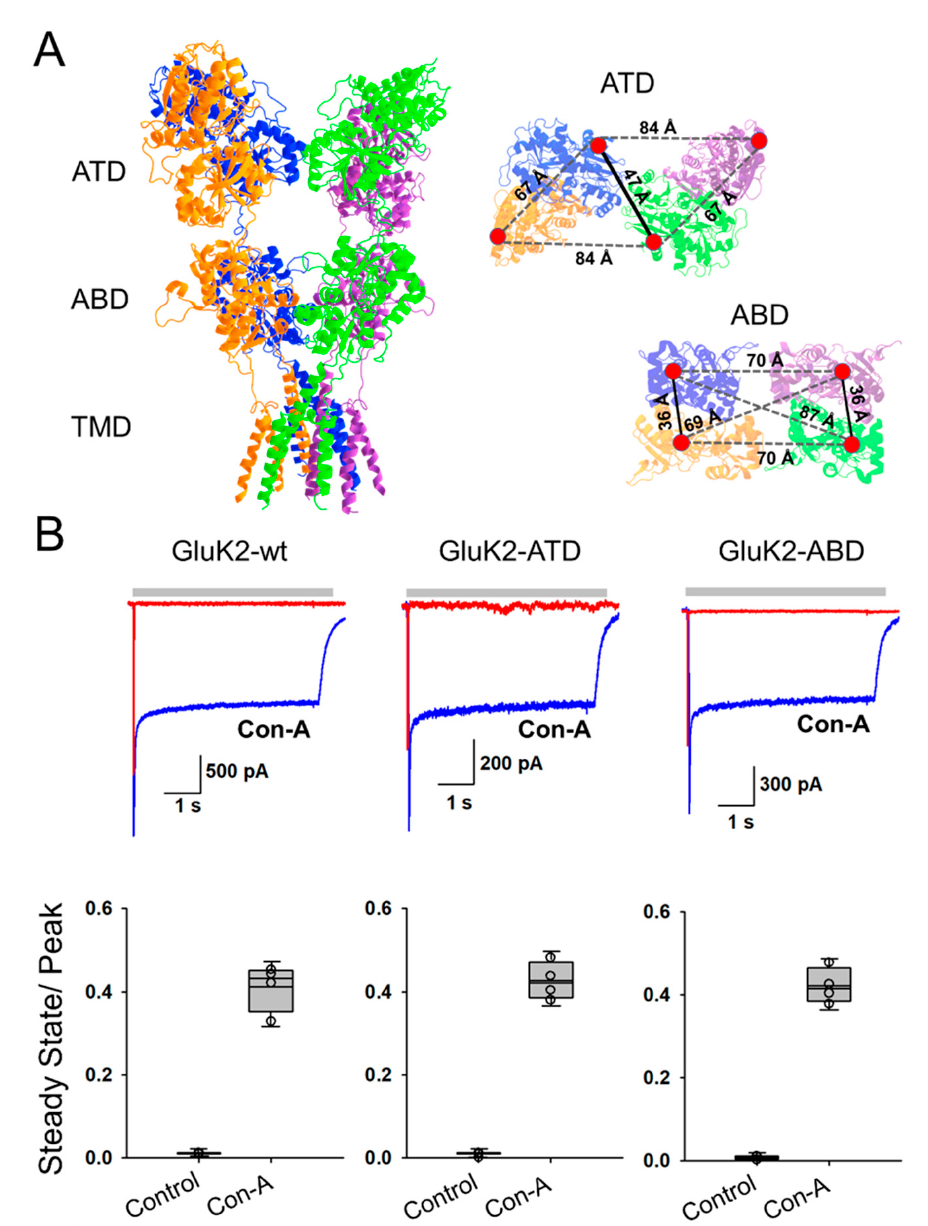
Figure 1. Depiction of the structural arrangement of homomeric GluK2 receptor and fluorophore conjugation sites. ( A ) Cryo-EM structure of a homomeric GluK2 receptor (PDB:5KUF) displaying the amino-terminal domain (ATD), agonist-binding domain (ABD), and transmembrane domain (TMD) and sites of fluorophore conjugation at the ATD (266) and ABD (479); top-down view shown for ATD (PDB:5KUF) and ABD (PDB:5KUH) with distances between sites 266 and 479, respectively. ( B ) Representative whole-cell recordings with 1 mM of glutamate for GluK2-wt, GluK2-ATD, and GluK2-ABD in the presence (blue) or absence (red) of 40 µM of Con-A (top) along with the ratio of steady-state to peak currents obtained from at least three different cells (bottom). These data show higher steady-state currents in the presence of Con-A.